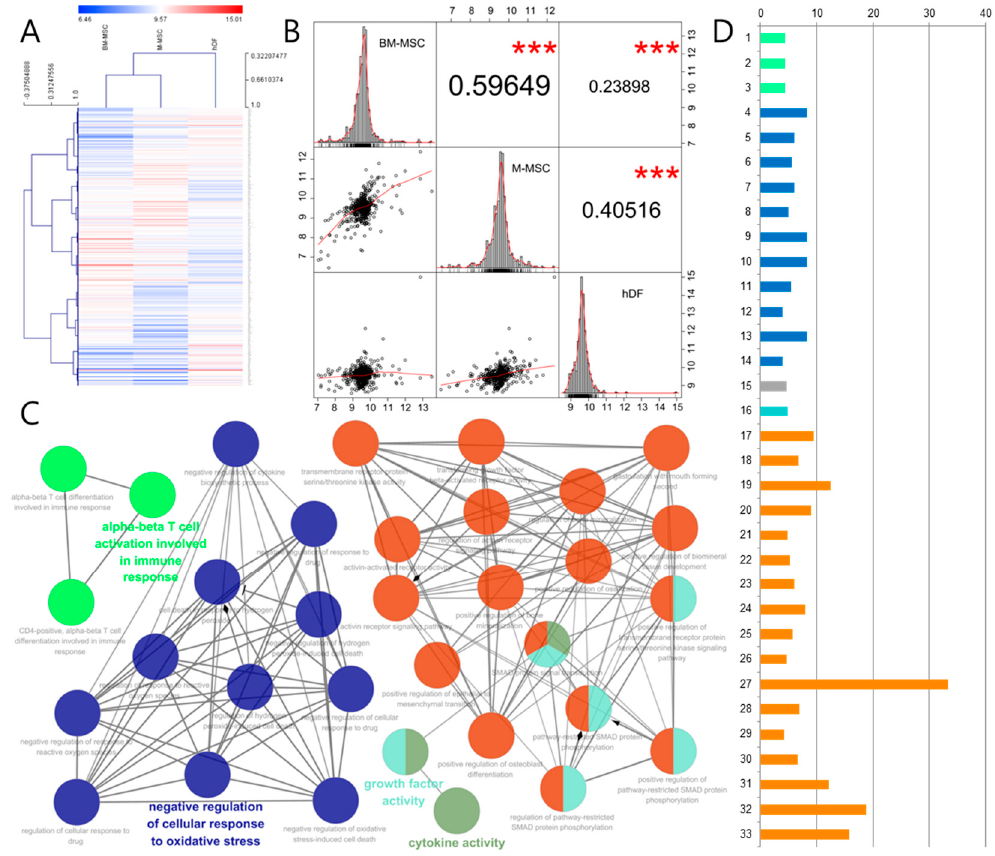
Figure 1. Characterization of M-MSCs (multipotent mesenchymal stem cells) via comparison with bone marrow-derived mesenchymal stem cells (BM-MSCs). M-MSCs and BM-MSCs’ supernatants and lysates were analyzed using L507 antibody array. ( A ) Heatmap of the supernatant of M-MSC, BM-MSC, and human dermal fibroblast (hDF). The color scale at the top represents the expression level, where red, blue, and white colors indicate upregulation, downregulation, and unaltered expression, respectively. ( B ) Correlogram with the significance values between M-MSC, BM-MSC, and hDF. The protein expressions of the cells are scattered as dots and their distribution is shown on the diagonal. Bivariate scatter plots with a fitted line are displayed on the bottom of the diagonal, and the values of the correlation and their significance level are displayed on the top of the diagonal ( p = 0, ***). Biological processes enriched amongst proteins in M-MSCs than BM-MSCs are shown in a ClueGO enrichment map. ( C ) Each node represents a significantly enriched biological process ( p < 0.05). ( D ) % genes / term for each node in ( C ) are shown. Features included each node are listed in the Supplementary Materials.